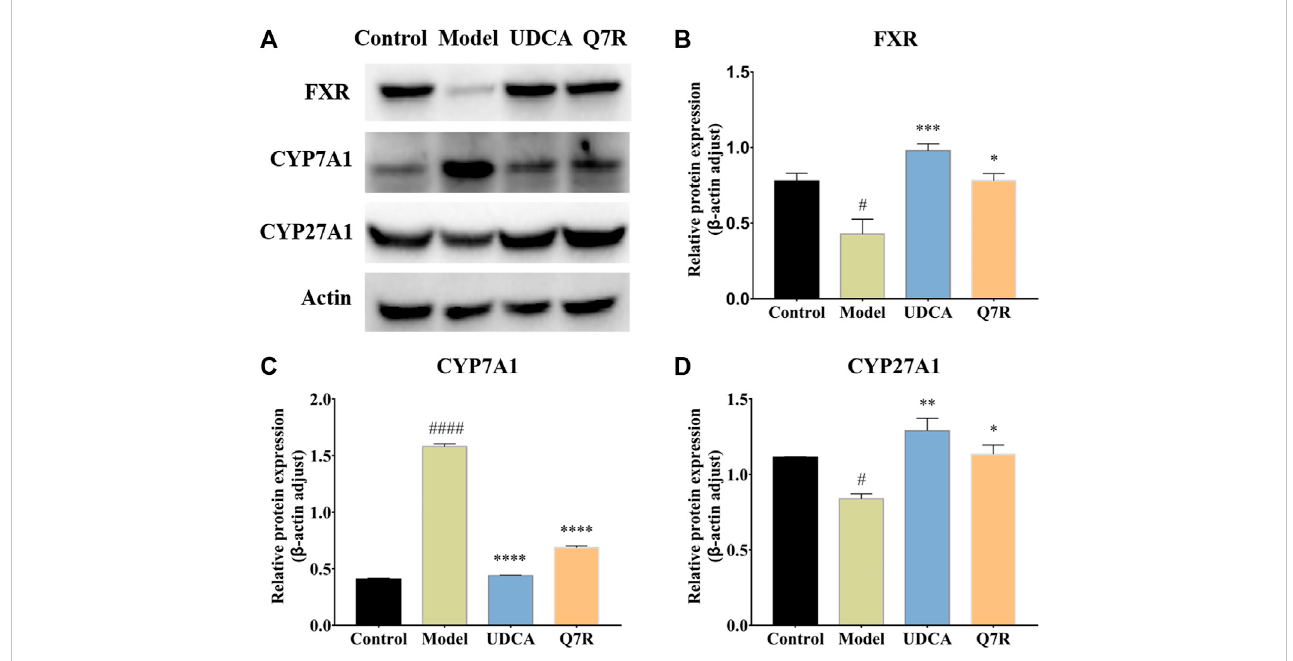
Western blot analysis for FXR, CYP7A1 and CYP27A1 protein levels in the liver of model rats ( n = 3). (A) Western blot analysis of FXR, CYP7A1 and CYP27A1 protein levels; (B) Relative protein of FXR was quantitatively expressed by densitometric analysis, β -Actin was served as an internal control; (C) Relative protein of CYP7A1; (D) Relative protein of CYP27A1. Values are presented as mean ± SEM for three biological replicates per group. * p < .05, ** p < .01, *** P < , **** p < .001 vs. the model group, # p < .05, #### p < .001 vs. the control